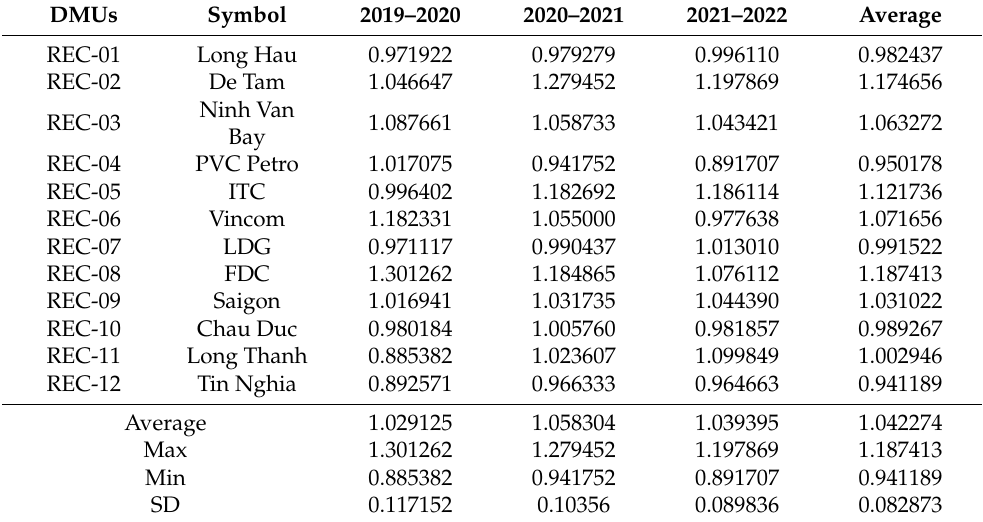
Table 11. Frontier-shift (2019–2022).